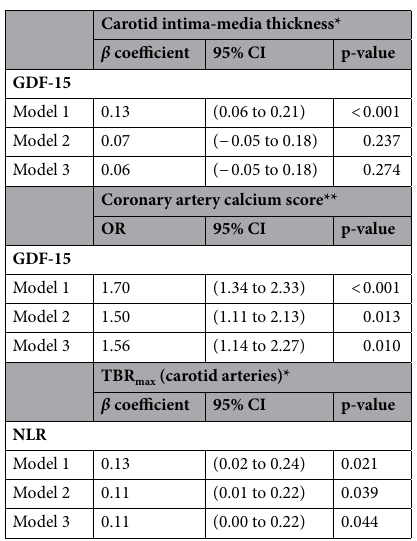
Table 3. Analyses of growth differentiation factor-15 (GDF-15) and neutrophil-to-lymphocyte ratio (NLR) associations with carotid intima-media thickness, coronary artery calcium score, and vascular inflammation in the carotid arteries, respectively, in patients with psoriasis without cardiovascular disease and statin treatment. Model 1, crude results; Model 2, after adjustment for the America College of Cardiology/American Heart Association (ACC/AHA) risk score; Model 3, after adjustment for ACC/AHA risk score and high-sensitivity C-reactive protein. TBR max maximum target-to-background ratio, OR odds ratio, CI confidence interval. *Linear -and multivariable regression models were performed to assess the association between GDF-15 and NLR and carotid intima-media thickness and vascular inflammation, respectively, in the carotid arteries. **Ordinal logistic regression was performed to assess the association between GDF-15 and the coronary artery calcium